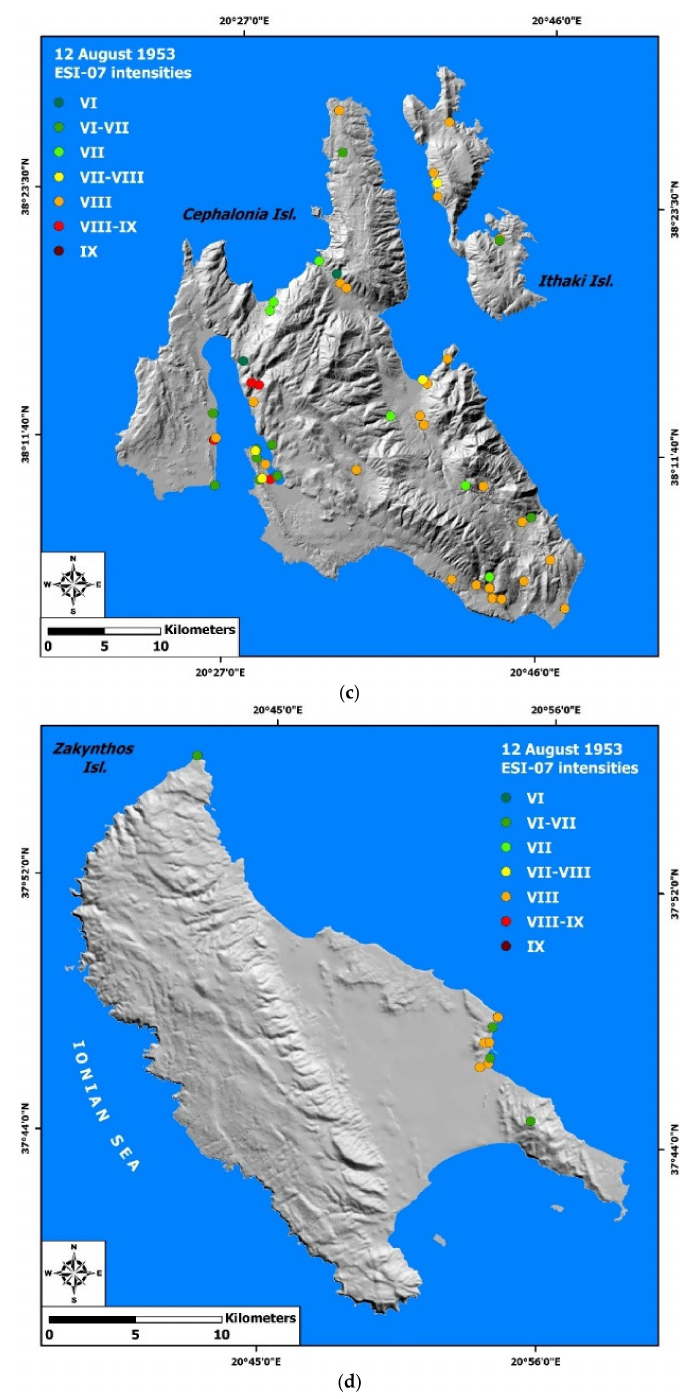
Figure 21. ESI-07 intensities for the primary effects induced by the 12 August 1953 earthquake in ( a ) Cephalonia and ( b ) Zakynthos as well as for secondary effects induced in ( c ) Cephalonia and Ithaki and ( d )